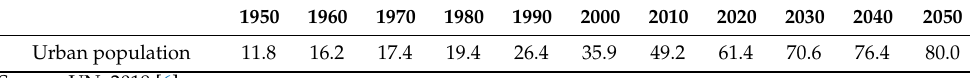
Table 1. Urban population in the China as a percentage of the total population, 1950 to